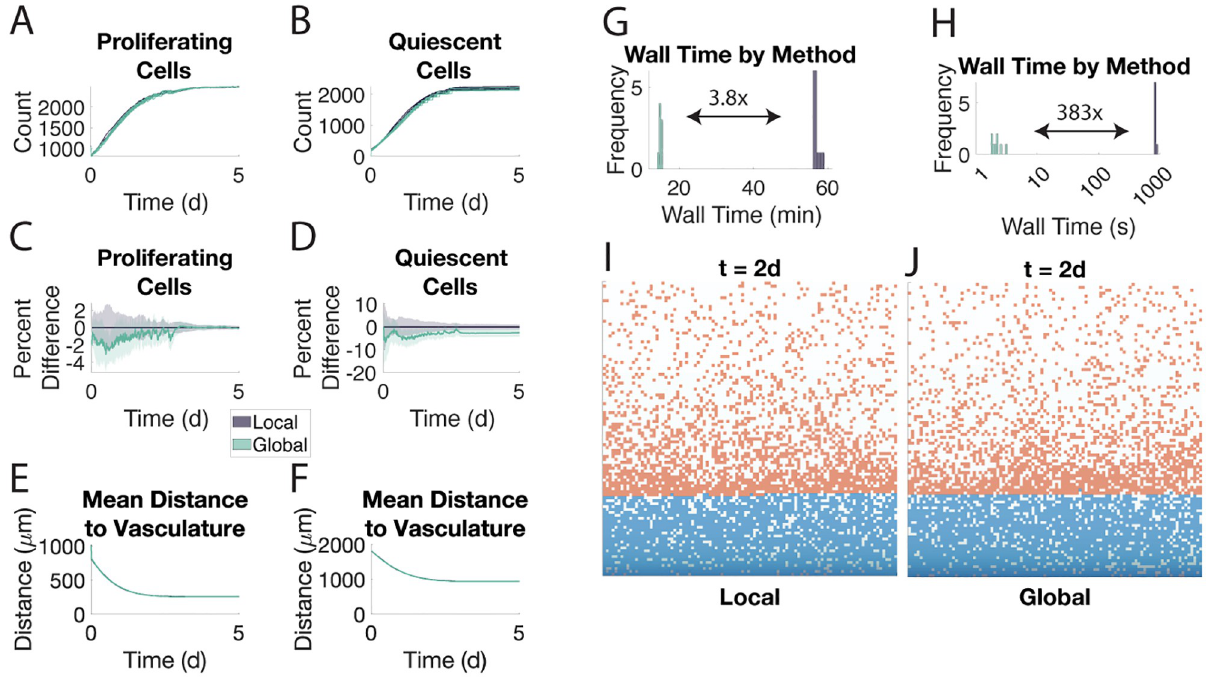
Fig 2. The global method agrees with the local method. Eight samples of each method are shown. Shaded area in A-F represents ± 1 SD from the mean. A. Proliferating cell population in both methods. B. Quiescent cell population. C-D. Percent difference from the average population in the local method. E-F. Mean distance of proliferating (E) and quiescent (F) cells from the vasculature at the bottom of the microenvironment. G. Wall time of each method when using direct Euler to solve the intracellular signaling ODEs. H. Wall time of each method when using a Runge-Kutta method to solve the intracellular signaling ODEs for only 2 minutes. I-J. Snapshots of the local (I) and global (J) methods at t = 2 d. Proliferating cells are in blue, quiescent cells are in orange.